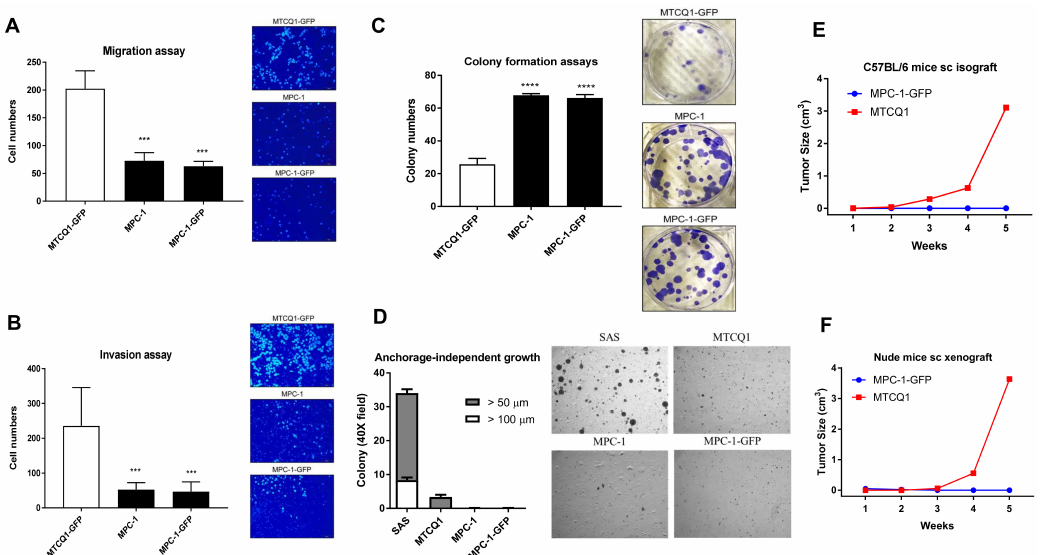
Figure 3. Phenotypic analysis of MPC-1 and MTCQ1. ( A ) Migration. Magnification: × 100. ( B ) Invasion. Magnification: × 100. ( C ) Colony formation. Magnification: × 2. *** p < 0.001; **** p < 0.0001. ( D ) Anchorage-independent growth. Magnification: × 100. ( A – D ), Left panels, quantification. It is performed 48 h (in A , B ) and 10 day (in C , D ) after cell seeding from at least duplicate analysis. Right panels, the representative fields or study sets. The SAS cells in ( D ) act as a side-by-side control. ( E , F ) Subcutaneous tumorigenesis in C57BL / 6 mice and nude mice, respectively. MPC-1, n = 10; MTCQ1 (for side-by-side control), n =